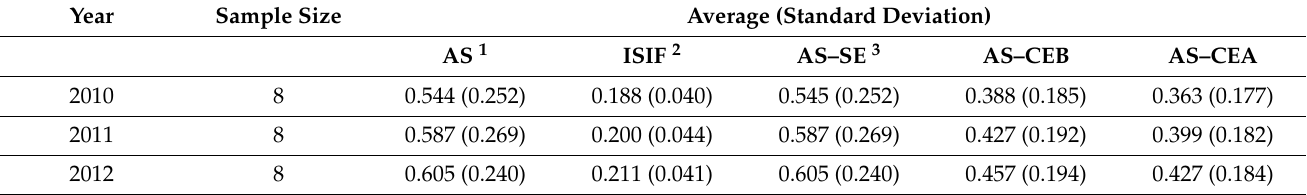
Table 11. All financial inclusion measures by